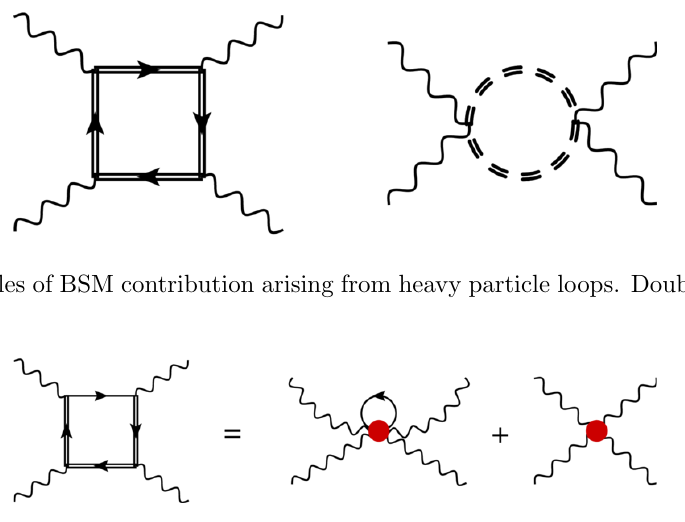
Figure 5 . If the leading BSM loop contribution contains SM (cid:12)elds in the loop, the diagram needs to be matched to both tree-level and loop-level diagrams in the EFT. Red blobs represent higher-dimensional